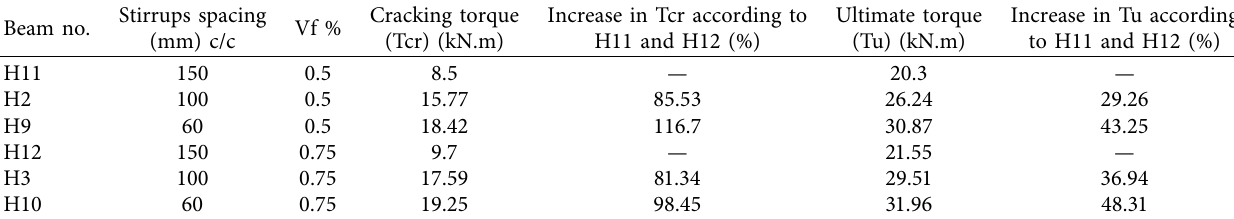
Table 7: Effect of spacing of stirrups on the beam torsional moment.